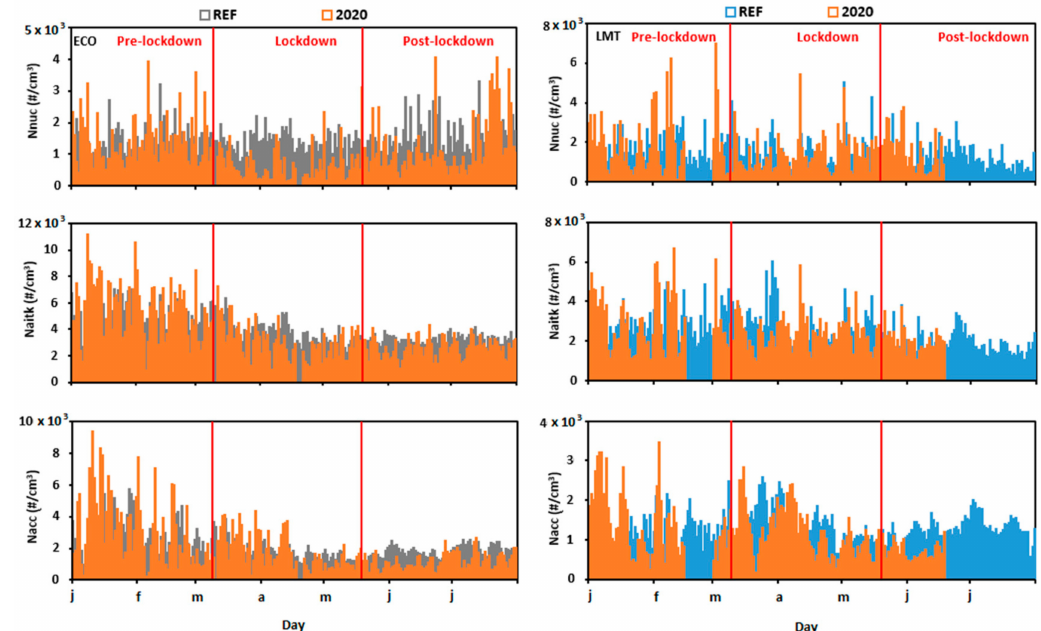
Figure 2. Comparison of daily variation of particle number concentration (PNC) for each size range (N nuc (Dp < 20 nm), N aitk (20 nm < Dp < 100 nm) and N acc (100 nm < Dp < 800 nm)) at ECO (on the left) and LMT (on the right). The red lines refer to 2020, and the gray and blue lines refer to reference years (2015–2019),